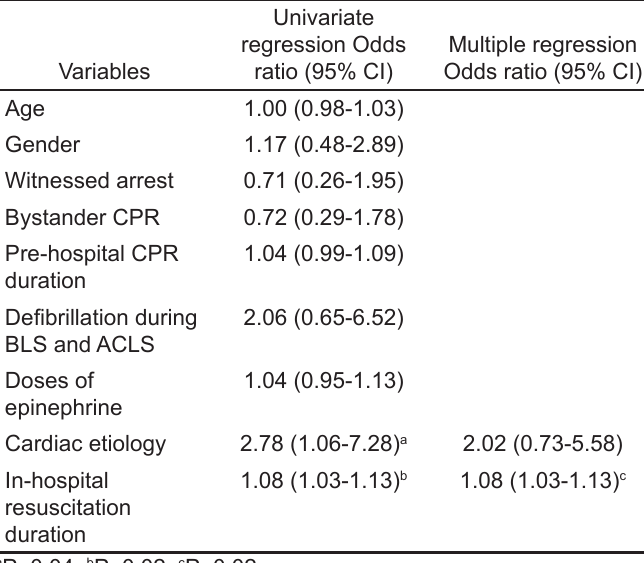
Table 2. The cardiac arrest event and resuscitation characteristics. Table 3. Variables for patients receiving ultrasonography during resuscitation.